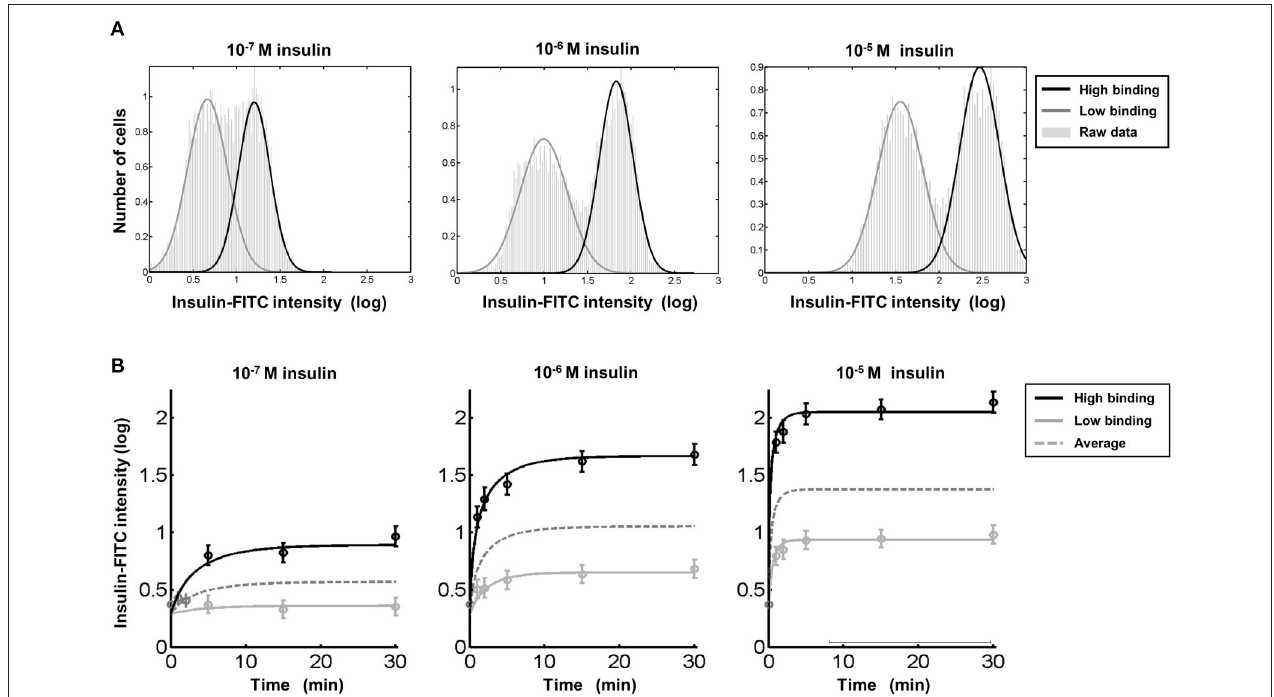
FIGURE 7 | Insulin binding differs in hepatocytes with diploid and polyploid nuclei despite comparable time kinetics. (A) The low and high insulin binding hepatocytes could be found by flow cytometry at any insulin concentration tested. A mixture of two Gaussian densities is fitted to each data set to estimate the dose dependency in detail (Supplementary Information and Figures 5 , 6 ). (B) The two entities arise immediately after the addition of insulin at all of the tested concentrations and have comparable saturating kinetics. The average shown as dashed lines represents insulin binding as it would be observed if the two types of hepatocytes could not be distinguished. For t = 0 as well as for the first three time points at the lower dose (left), the individual averages of both entities could not be calculated without a bias. Therefore, only the average over both entities is plotted and used for fitting of the kinetic